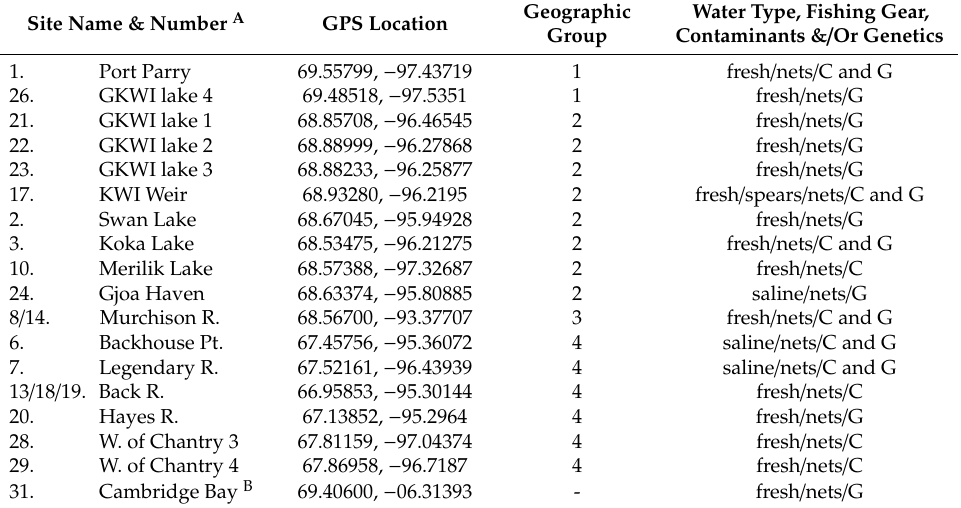
Table1. FishingsitessampledintheKitikmeotregionofNunavut, Canada, showingfishingsitenumbers and names or designations, global positioning system coordinates, geographic group assignments, as well as water type (fresh or saline), fishing gear used, and if samples from this location were analyzed for contaminants ( C ) and / or genetics ( G